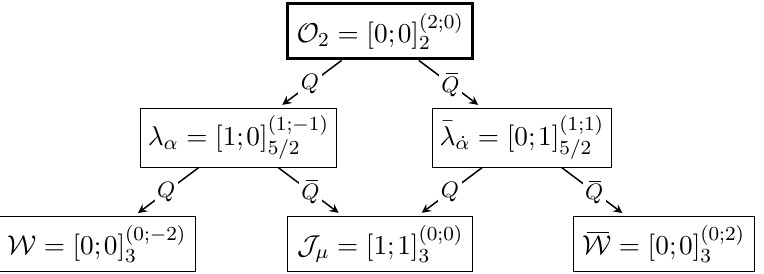
¯ , where ‘ and ¯ ‘ ‘ ] ( R ; r ) ∆ symmetry, r to the U(1) and ∆ R r